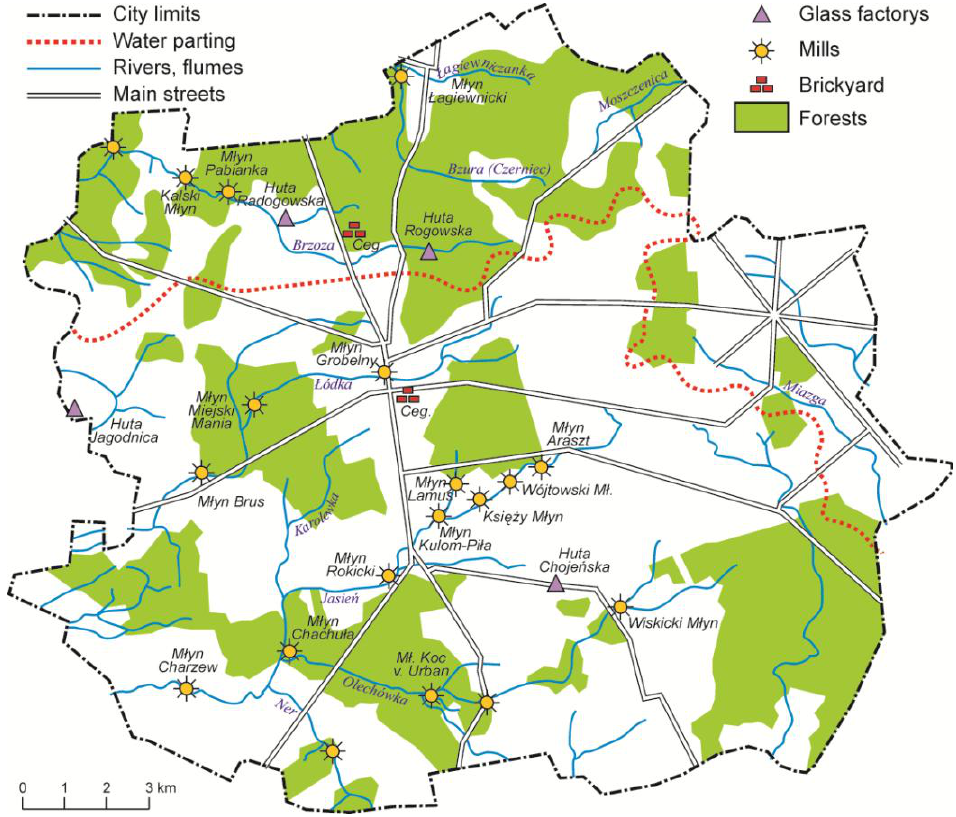
Fig. 2. River network in the Łódź area at the beginning of the 19 th century, showing the glassworks and brickyards (source: Szkurłat,